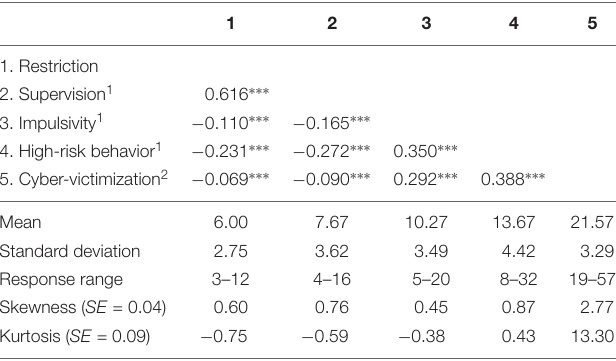
TABLE 1 | Descriptive statistics and correlation coefficients between the variables in the starting theoretical